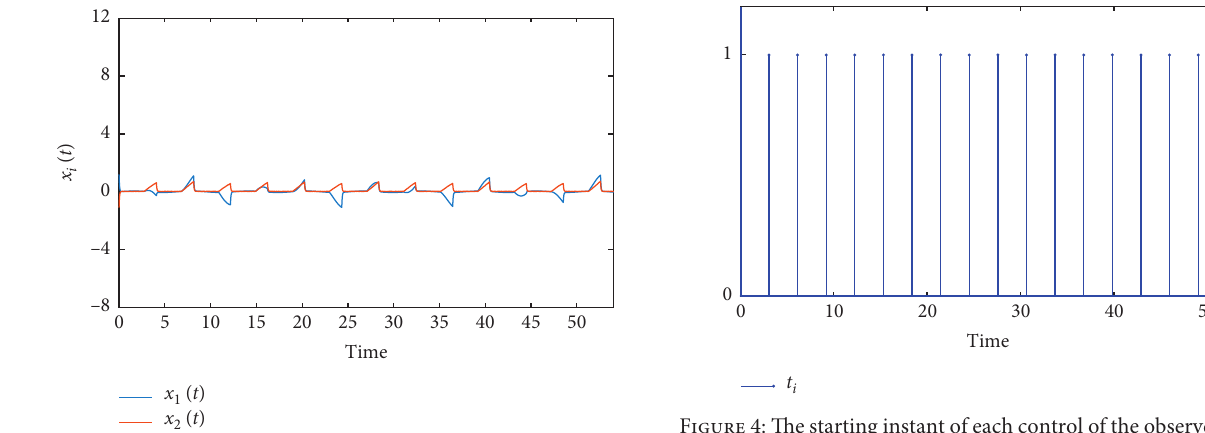
( i � 1 , 2 ) of system (112) under the i